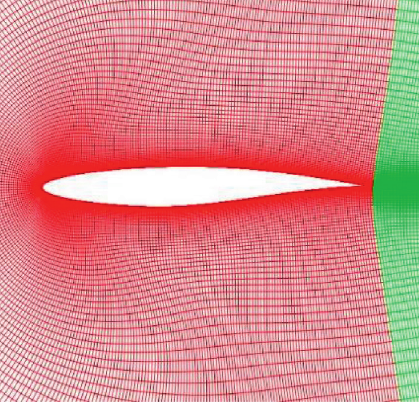
Figure 2: Grid of calculation field. Table 1: Steady computational condition.